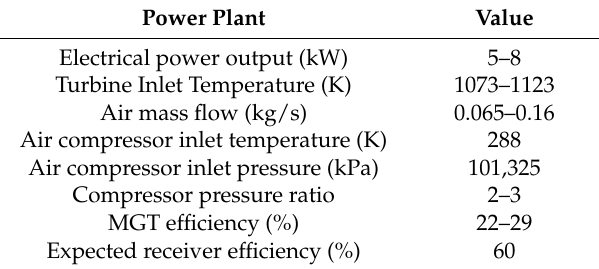
Table 1. Reference power plant main